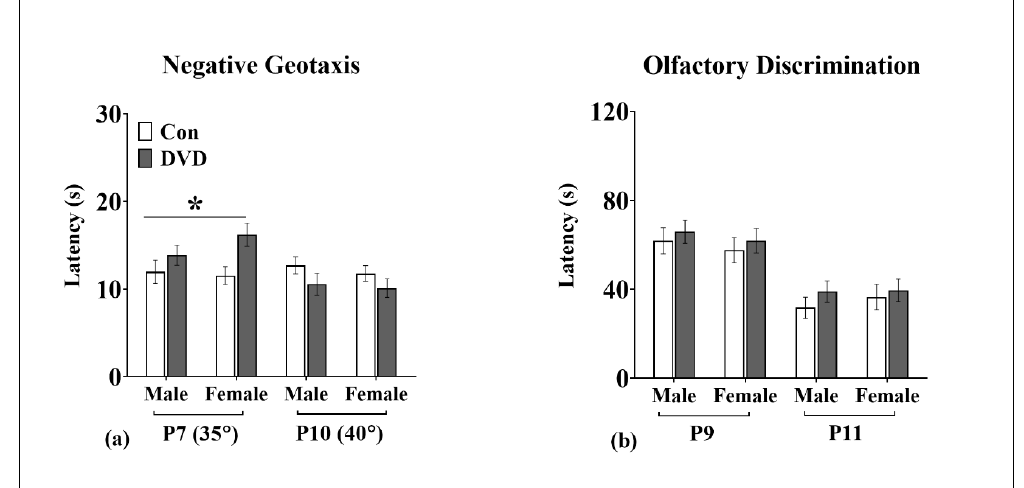
Figure 4. Negative geotaxis and olfactory discrimination (Cohort 2). (a) Negative geotaxis was tested P7 and P10. Both DVD-deficient male and female pups had a delayed latency to attain negative geotaxis compared to controls at P7 with no difference among the diet groups at P10. DVD males n = 42, control males n = 29, DVD females n = 34 and control females n = 30. Data shown is mean time taken by pups to complete a 180° turn in seconds. (b) Olfactory discrimination was tested at P9 and P11. There was no effect of DVD-deficiency on olfactory discrimination in both male and female pups at both testing days. DVD males n = 50, control males n = 44, DVD females n = 63 and control females n = 43. Data shown is mean latency to reach the home bedding side measured in seconds. Error bars show SEM, * p < 0.05, P = postnatal day.